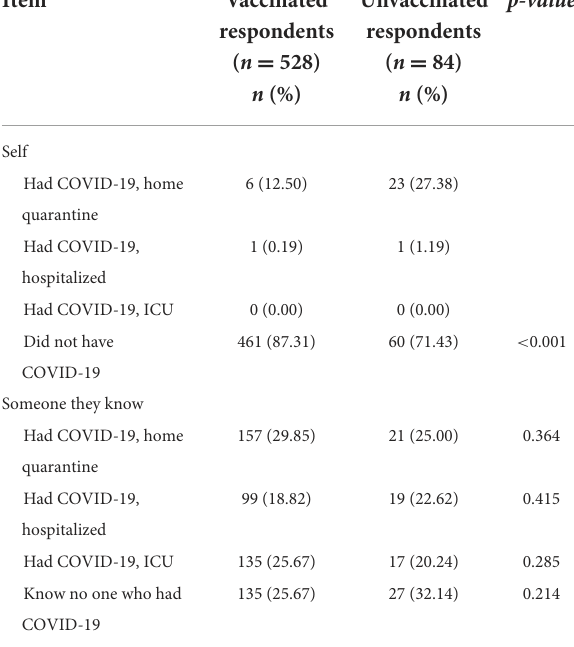
TABLE 6 COVID-19